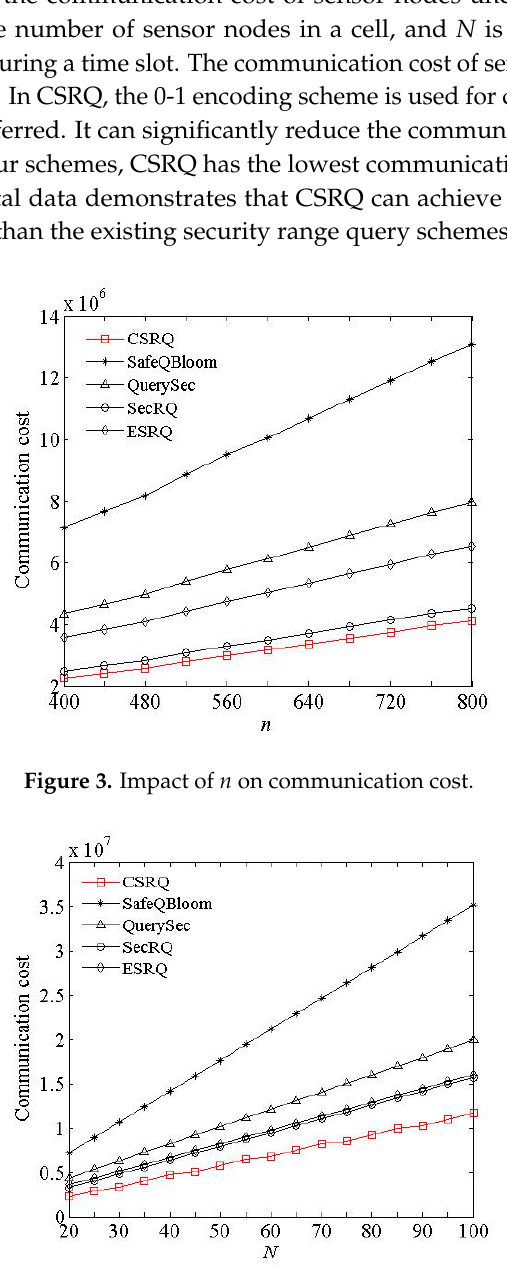
Figure 5. Impact of w on communication cost.